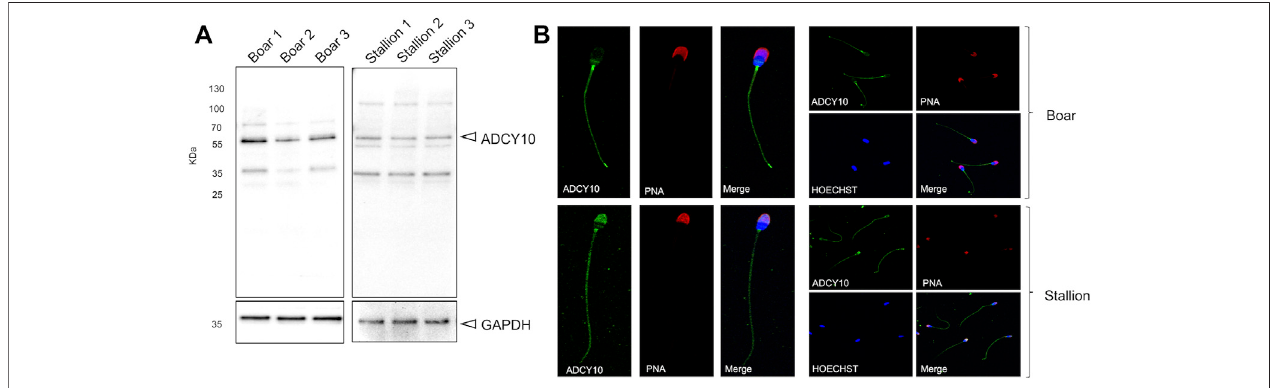
FIGURE 2 | Detection and localization of ADCY10 in stallion and boar spermatozoa. Native semen samples were processed for immunoblotting and immuno fl uorescence withapolyclonalantibodyagainst ADCY10. (A) Immunoblotofanti-ADCY10inboar semensamples( n (cid:2) 3boars) and stallionsemensamples( n (cid:2) 3stallions).GAPDHwasusedasaloadingcontrol. (B) RepresentativeimagesforthelocalizationofADCY10inboarspermatozoaandstallionspermatozoa( n (cid:2) 3boars; n (cid:2) 3 stallions). Samples were counterstained with PNA-AlexaFluor ™ 647 (to visualize sperm acrosomes) and Hoechst 33342 (to visualize the